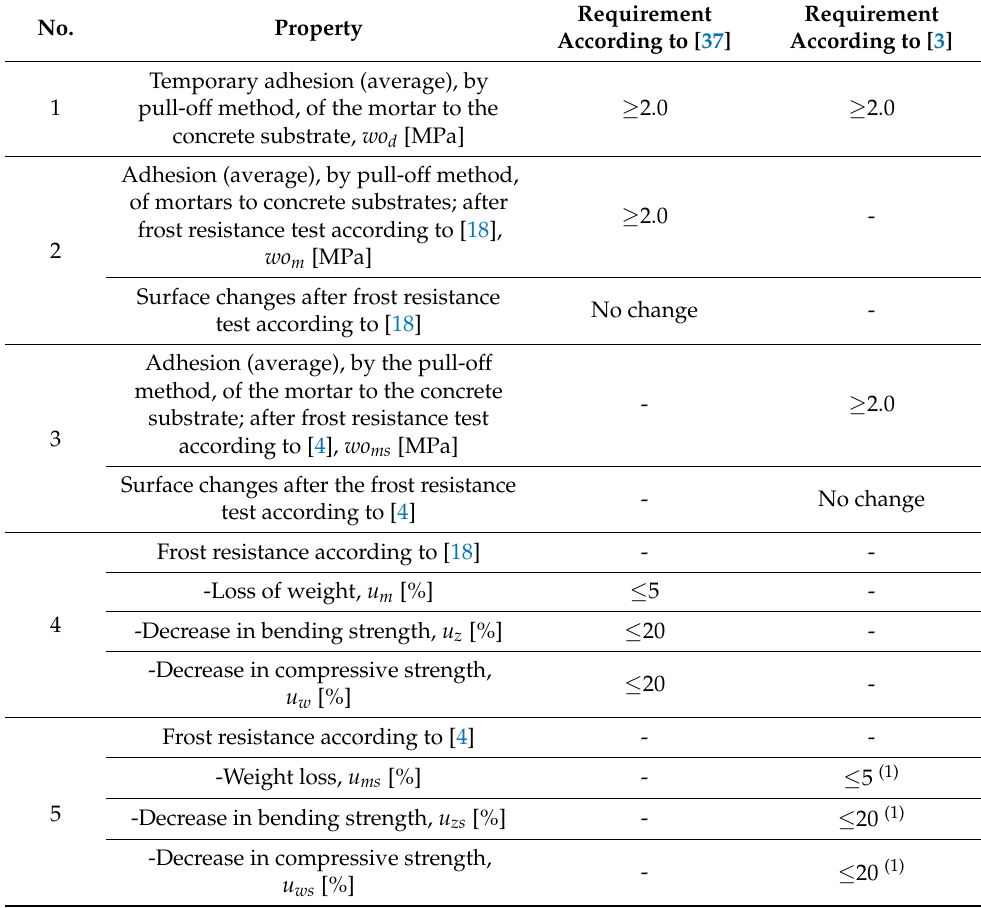
Table 2. List of tested mortar properties, including